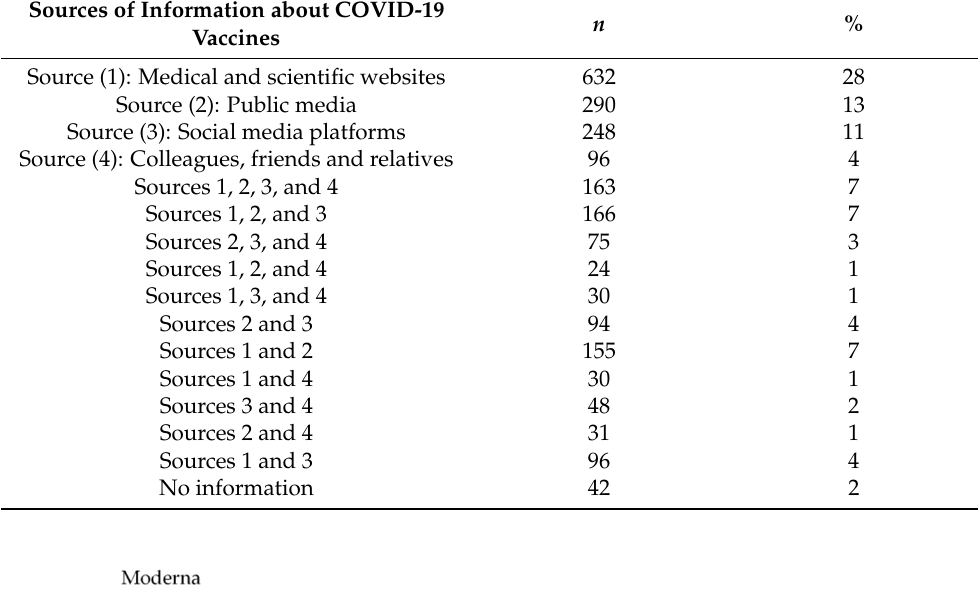
Table 2. The major sources for information about COVID-19 vaccines among participants.